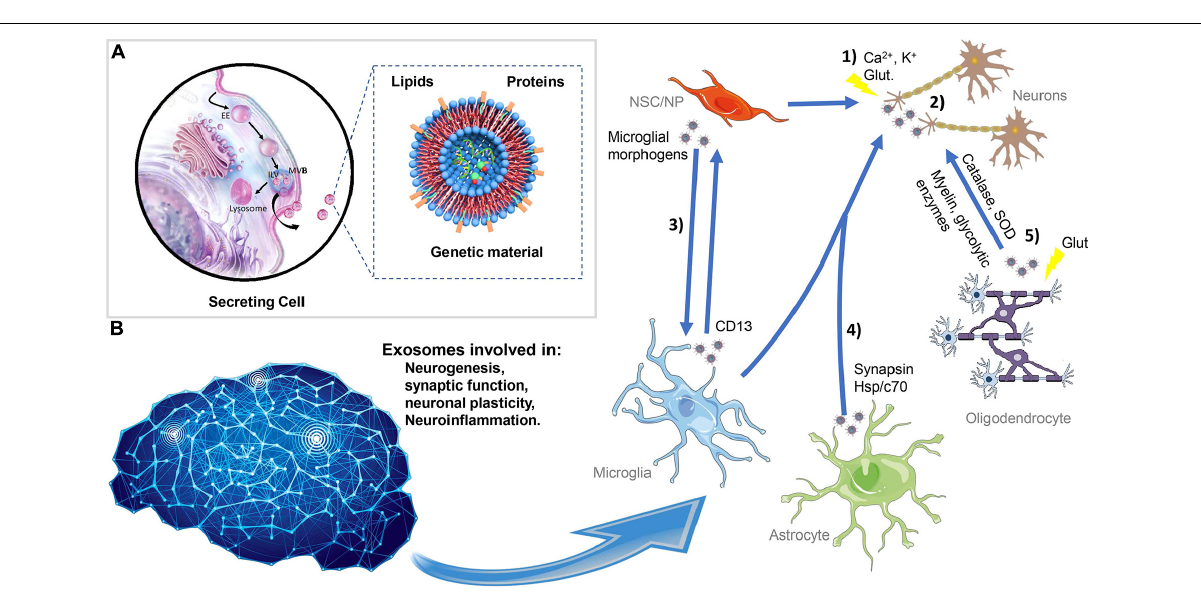
FIGURE 2 | Exosome biogenesis, secretion, and interaction in the central nervous system. (A) Exosomes originated in the endocytic pathway as ILVs resulting in the formation of LE with multiple small vesicles termed MVBs. During this process, exosomes are loaded with proteins, lipids, and genetic material. Afterward, the MVBs can be destined for lysosomal degradation or fused with the plasma membrane and the exosomes released into the extracellular space. The exosomes have a complex composition of proteins such as ALIX, TSG101 and flotillin, Rab family, tetraspanins (e.g., CD63, CD81, and CD9), mitochondrial proteins, and others; lipids including cholesterol, sphingomyelin, glycosphingolipids, and ceramide; and nucleic acids especially RNA and also nuclear and mitochondrial DNA. (B) Exosomes can be released from NSC/NP, neurons, astrocytes, oligodendrocytes, and microglia acting in proximal or distal cells. Exosomes can be shuttled between the different neural cells modulating distinct neuronal processes such as neurogenesis, synaptic function, neuronal plasticity, and neuroinflammation. (1) In neurons, exosomes are released in response to stimulus, such as calcium influx, glutamatergic synaptic activity, and potassium-induced depolarization. (2) The exosome signaling pathways include neuron-to-neuron communication. (3) NSC can influence the microglia function, and exosomes released from glial cells exert effects on NSC. (4) Additionally, exosomes originated in astrocytes can be fundamental for the trophic support of neurons. (5) Oligodendrocytes can also shuttle to neuron exosomes containing myelin proteins and glycolytic enzymes. ILVs, intraluminal vesicles; EEs, early endosomes; MVBs, multivesicular bodies, NSC/NP, neural stem/progenitor